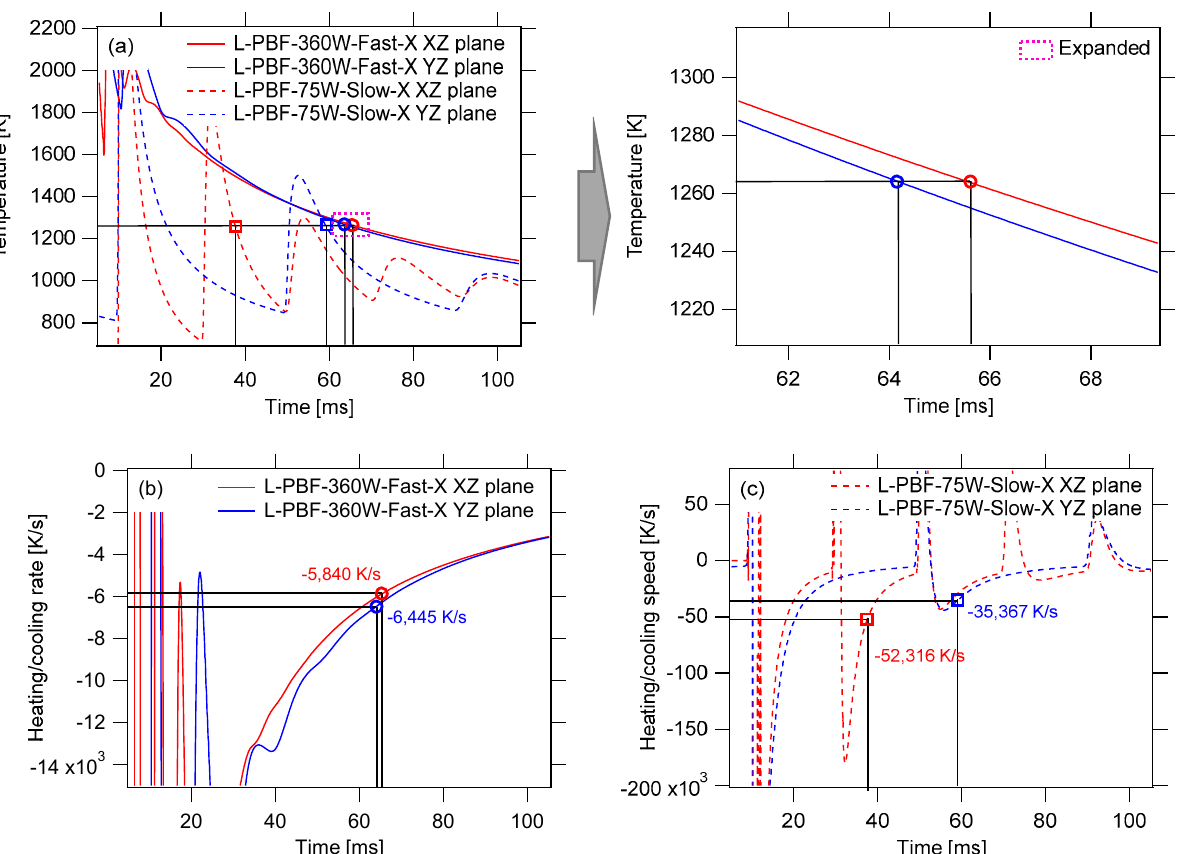
Figure 12. Heat transfer simulation for L-PBF-360W-Fast-X and L-PBF-75W-Slow-X: ( a ) Temperatures calculated at 20 µm depth from the center of the XZ and YZ plane surfaces for L-PBF-360W-Fast-X and L-PBF-75W-Slow-X; ( b ) Heating/cooling rates calculated at the same location for L-PBF-360W-Fast-X; ( c ) Heating/cooling rates calculated at the same location for L-PBF-75W-Slow-X. The moments the temperature reached the β transus temperature are marked as a red circle for the L-PBF-360W-Fast-X XZ plane, a blue circle for the L-PBF-360W-Fast-X YZ plane, a red square for the L-PBF-75W-Slow-X XZ plane, and a blue square for the L-PBF-75W-Slow-X YZ